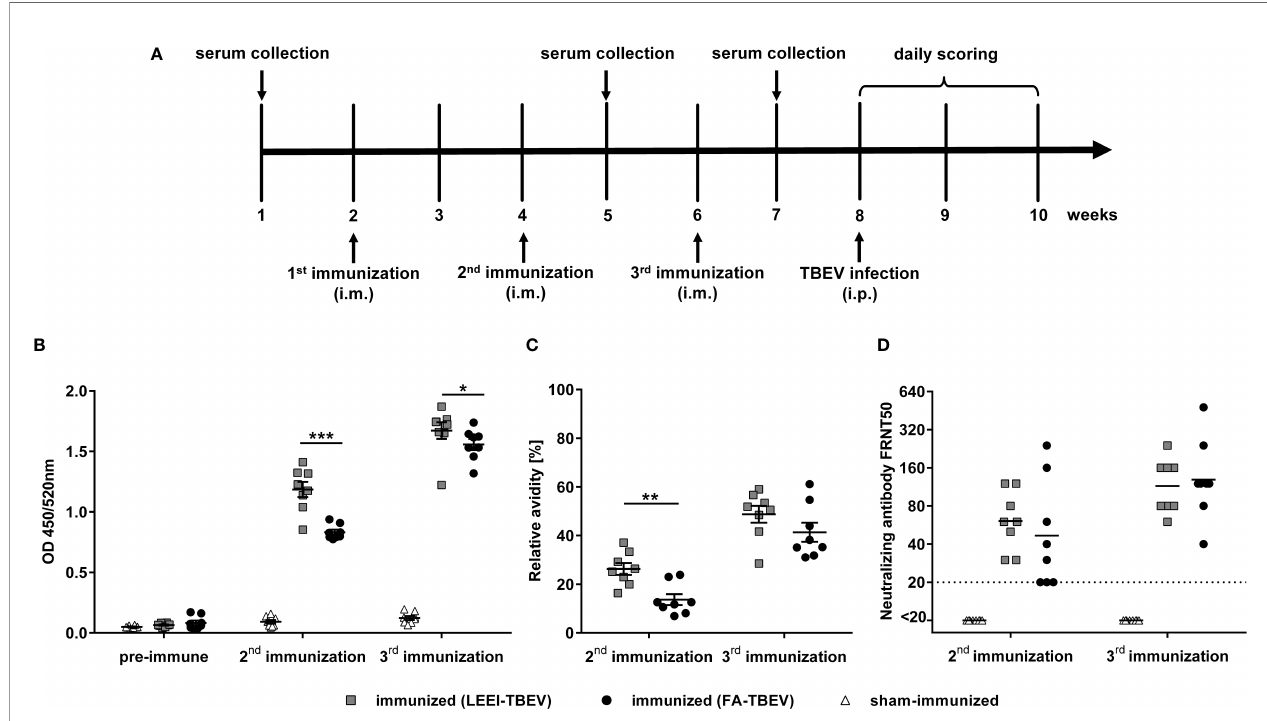
FIGURE 3 | Humoral immune responses after immunization with different inactivated TBEV vaccines. BALB/c mice (n=8) were immunized three times with TBEV inactivated either with 20 kGy LEEI (squares) or 0.05% FA (dots). Sham-immunized mice (triangles) received only buffer and adjuvant. (A) scheme of the immunization experiment. (B, C) Binding antibodies (B) and antibody avidity (C) were analyzed in IgG-ELISAs with untreated puri fi ed TBEV virions as coating antigen. For avidity measurement, the IgG-ELISA was performed with and without an additional urea wash step after the antibody binding. Both signals were compared in order to calculate the relative antibody avidity. Each data point represents an individual mouse of the same experiment. Data derive from two independent ELISA-assays, each serum sample measured in duplicates per run. Mean values of the groups ± standard error of the mean (SEM) are indicated. (D) Neutralizing activities of mouse sera were measured in focus reduction neutralization tests. The dotted line represents the lower detection limit (FRNT50 = 20). Shown are the neutralizing titers of individual mice and the geometric mean of each group. Data derive from two independent FRNT50 assays. All data were tested for normal distribution by a Shapiro- Wilk test. Statistical analysis of normally distributed avidity data was performed by an unpaired t-test. Binding and neutralizing antibodies were analyzed using an unpaired Mann-Whitney U-test ( ∗ p < 0.05; ∗∗ p < 0.01; ∗∗∗ p <